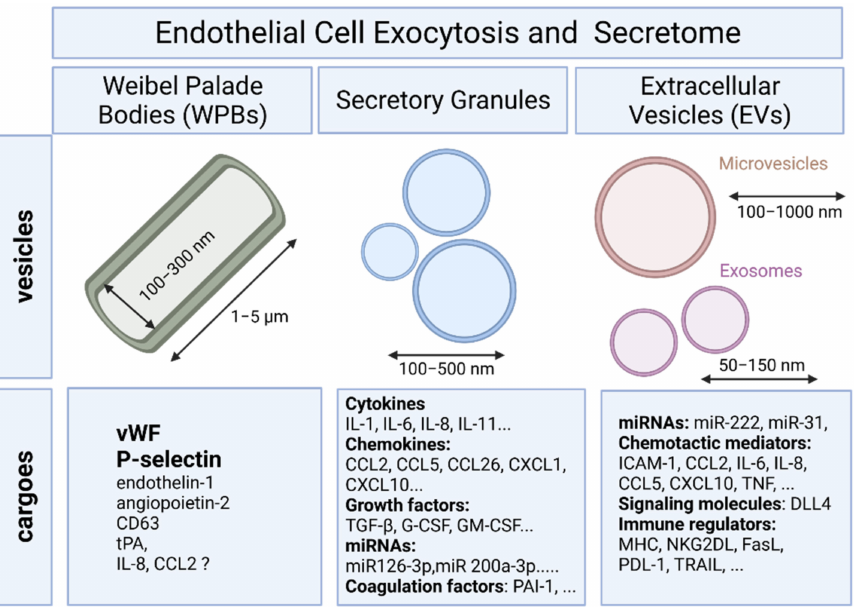
Figure 1. A schematic overview of secretory granules and extracellular vesicles and their cargoes in endothelial